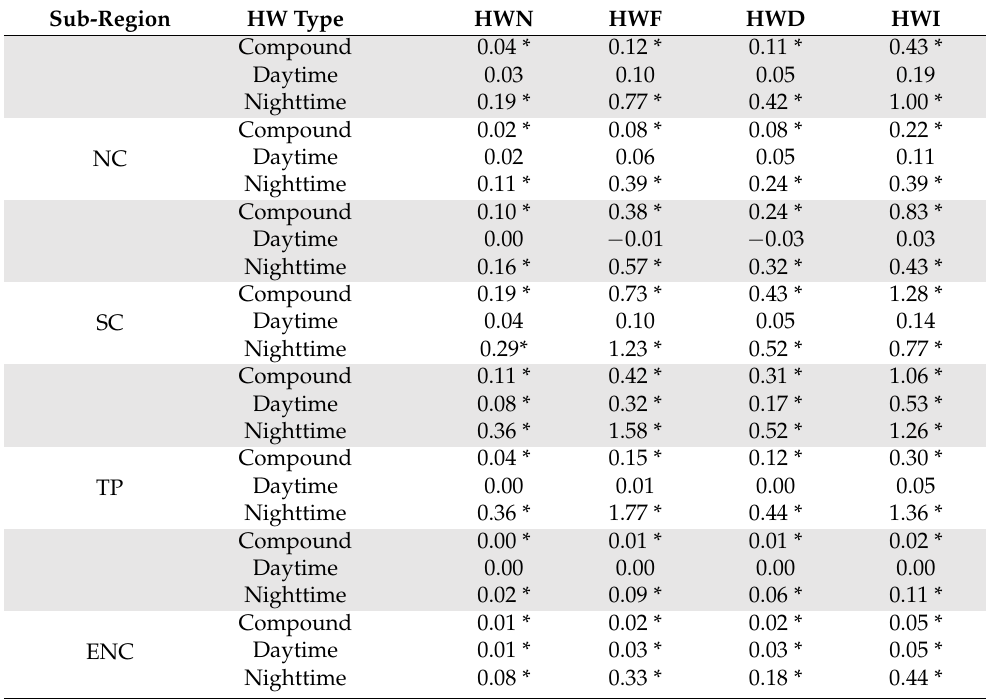
Table 2. Same as Table 1, but for the eight sub-regions of China.